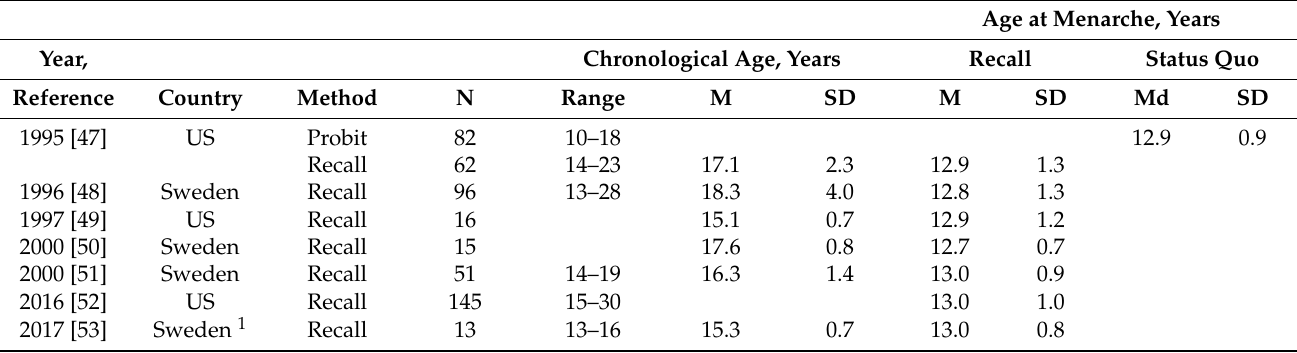
Age at Menarche, Years